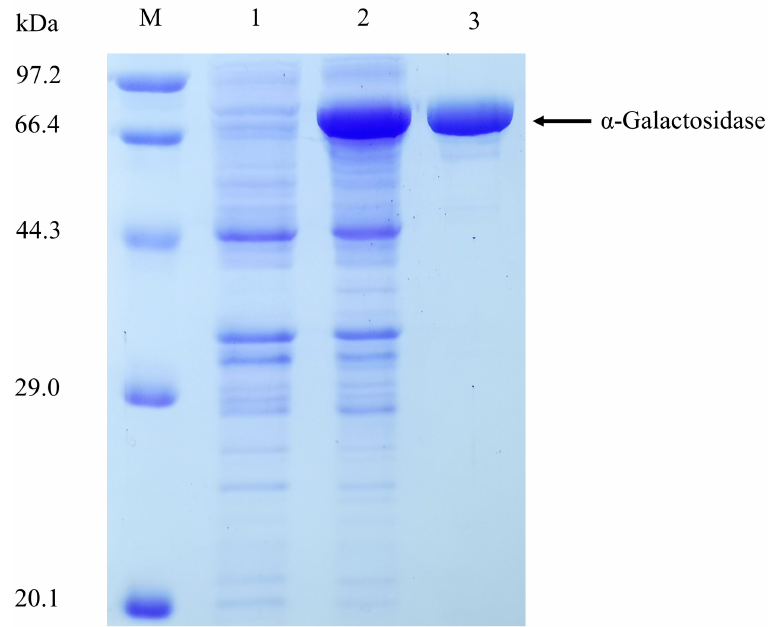
Figure 4. SDS-PAGE analysis of α -galactosidase expressed in E. coli BL21 (DE3). Lanes: M, protein molecular weight marker; 1, pET-28a; 2, crude pET-28a- α -galactosidase; 3, purified pET-28a- α -galactosidase.